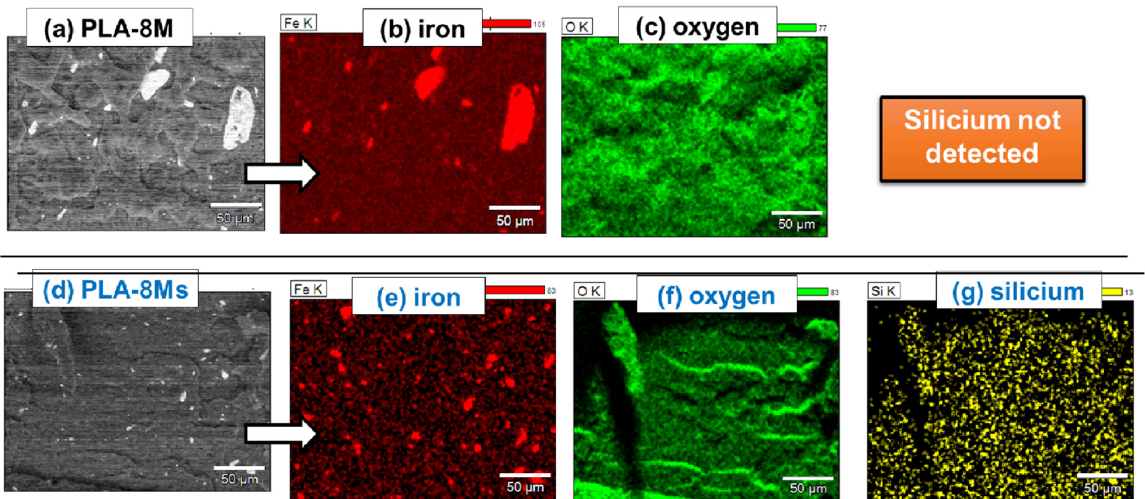
Figure 11. ( a – g ) SEM and EDX elemental mapping on PLA-8M ( a – c ) and PLA-8Ms nanocomposites ( d – g ) to evidence the presence of oxygen and iron as the main elements from magnetite nanofiller (presence of Si in PLA-8Ms (Figure 11g) is due to the treatment of NPs with MHX).